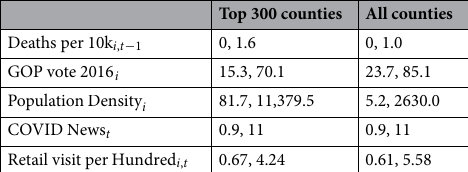
Top 300 counties All